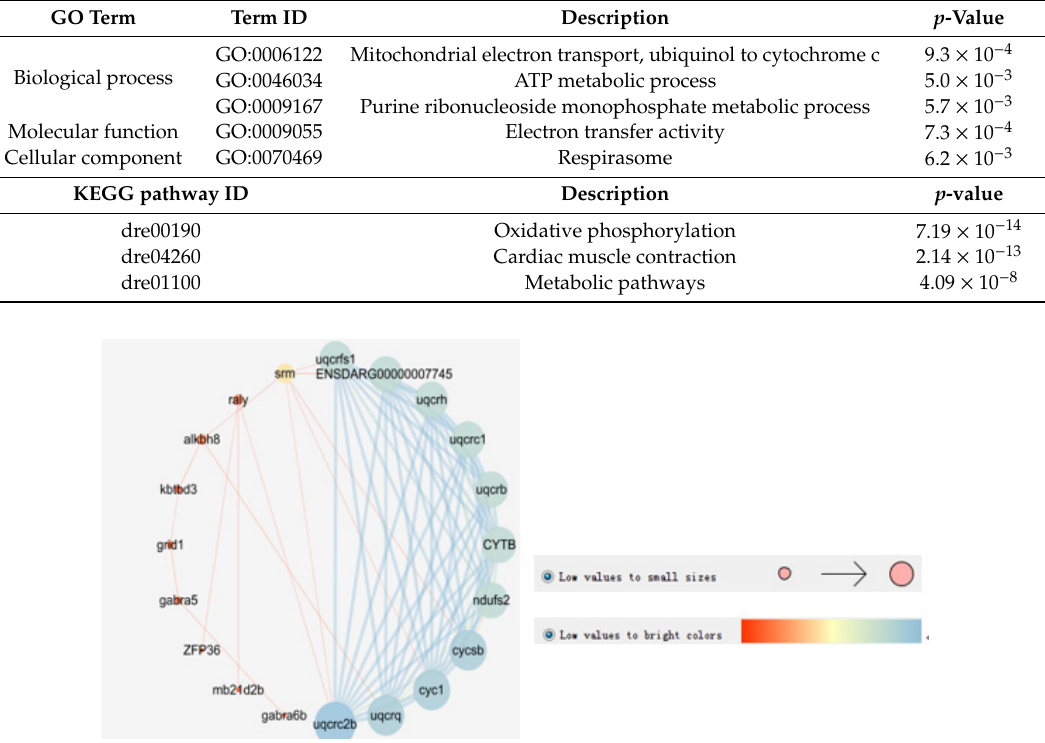
Figure 3. Illustration of the growth candidate gene core in Cytoscape.